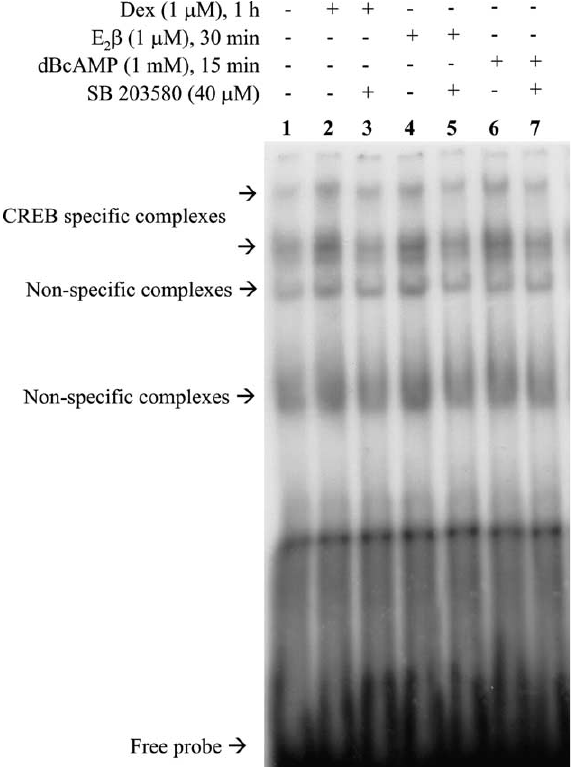
FIG. 6. SB203580 inhibits Dex-induced, E 2 b -induced and dBcAMP-induced CREB activation in CCRF-CEM cells. The cells were incubated in the presence or in the absence (control, lane 1) of the p38 inhibitor, SB203580 (40 m A), for 1 h. Then, the cells were further incubated with Dex (1 m M), E 2 b (1 m M) or dBcAMP (1 mM), for 1 h, 30 min or 15 min, respectively. Nuclear extracts were subjected to EMSA analysis as described in Materials and methods. The results shown are representative of three independent